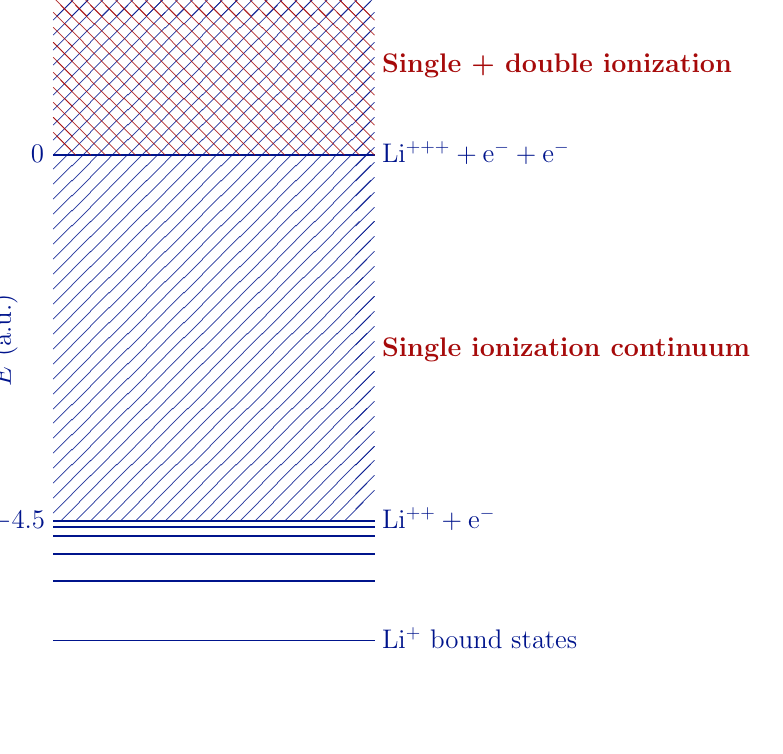
Figure 1. Energy level diagram for 6 Li + following the beta decay. For the E > 0 region, the single- ionisation continuum underlies the double-ionisation continuum, and so, both charge states con- tribute to the